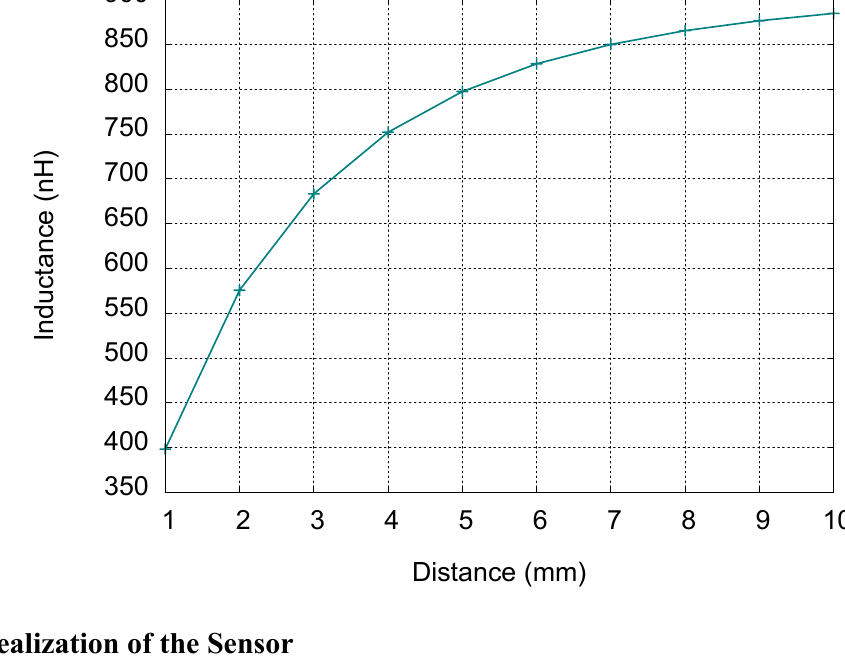
Figure 5. Simulation results: Inductance variation with distance